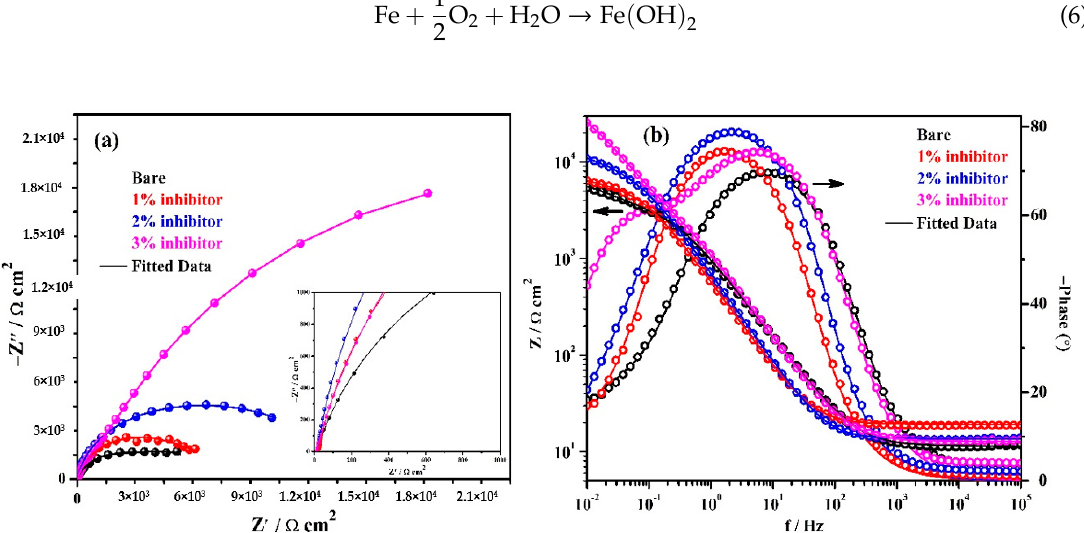
Figure 5. EIS plots. ( a ) Complex plane impedance and ( b ) Bode spectra of steel rebars after 24 h of exposure in SCP + 3.5 wt% NaCl solution with and without inhibitor.